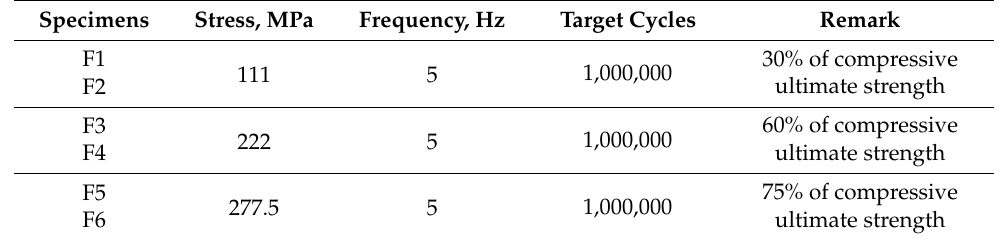
Table 2. Specimens in mechanical cycling